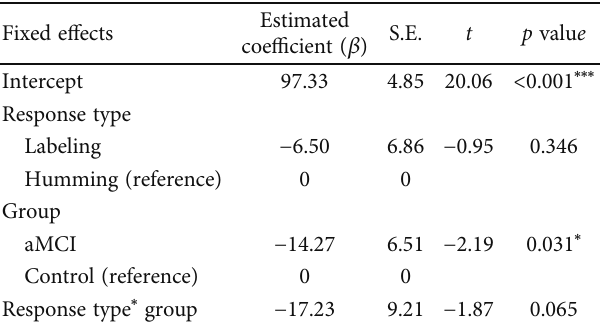
Table 3: Estimated fi xed e ff ects of predictors for duration pattern test.